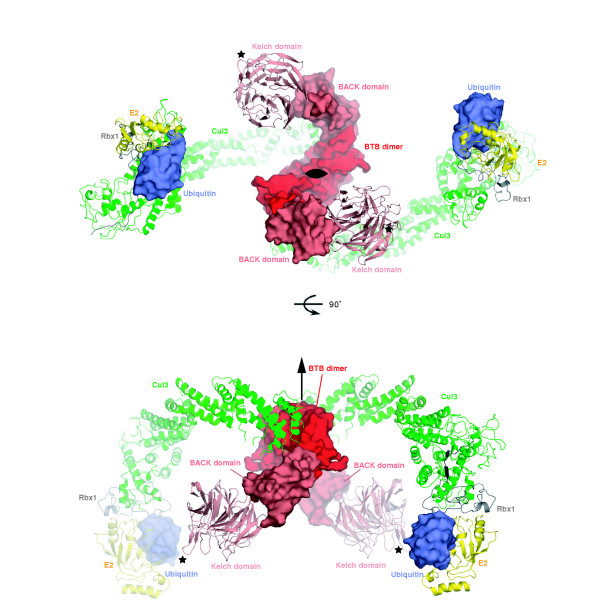
Structural model of the ubiquitin-E2-Cul3-Rbx1-BBK complex. The complex forms a dimer by the self-association of the BTB domain in the BBK protein. The approximate position of the two-fold axis is indicated. Each full-length BBK protein is shown in red, with the BTB dimer shown in the darkest shading in surface representation, the two BACK domains in pink surface, and the two Kelch β-propellers shown in pink cartoon representation. The Cul3 homology model is shown in green cartoon representation, Rbx1 is in gray cartoon representation, E2 Ubch7 is in yellow cartoon representation, and ubiquitin is shown as a blue surface. Stars indicate the position associated with substrate binding [114]. Depth cuing is used to indicate distances in the plane of the page, such that the diffuse colors are most distant to the viewer than the intense colors.